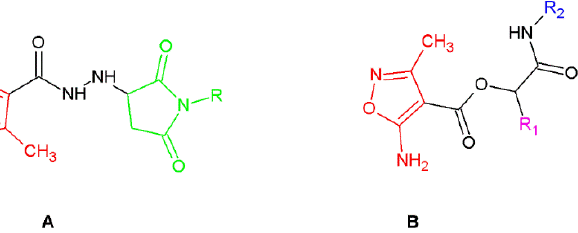
Figure 1. Designed isoxazole derivatives (( A ) MAL1-5 series; ( B ) PUB1-10 series: R1-aldehyde/ketone residue; R2-isocyanide residue).